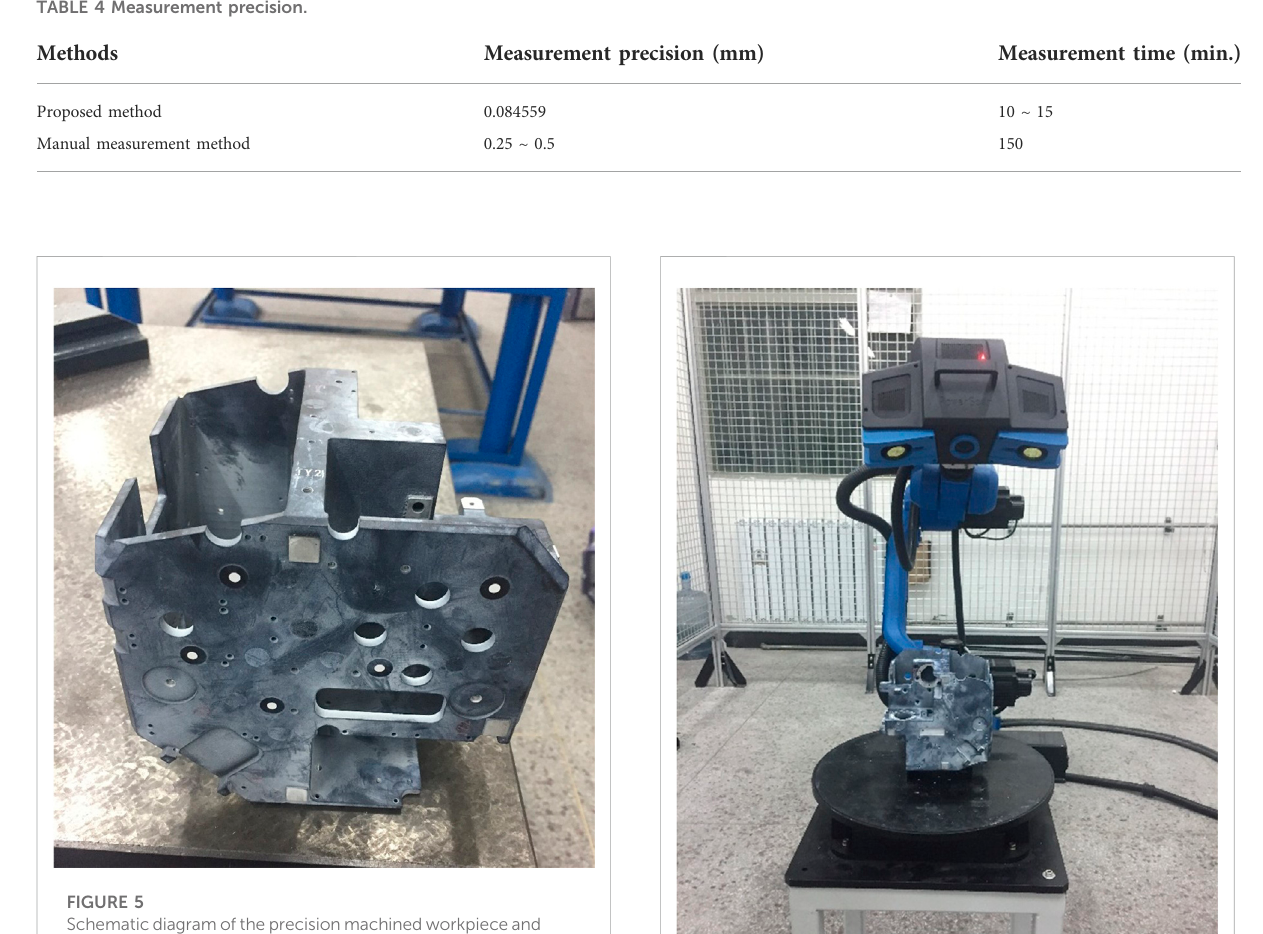
TABLE 4 Measurement precision.